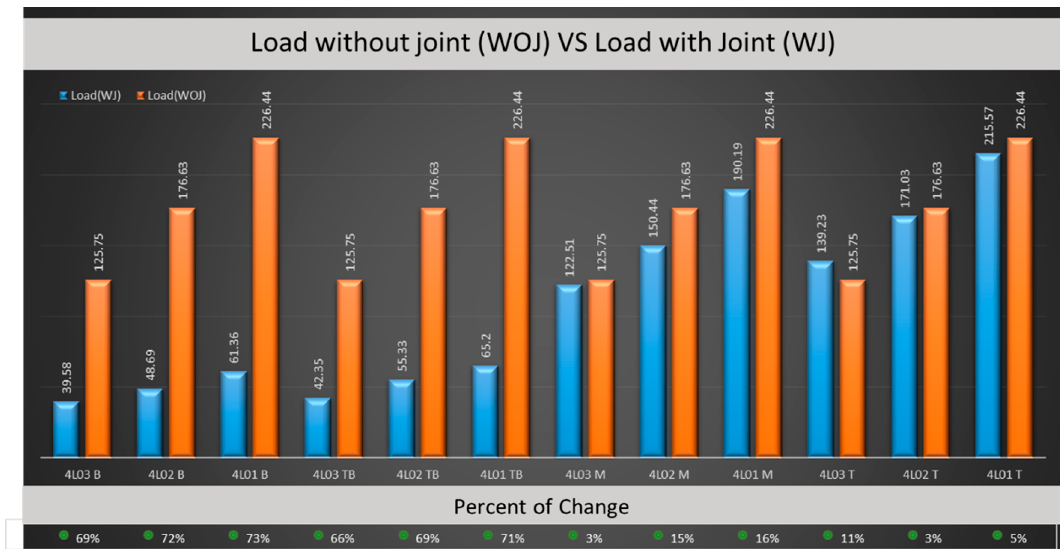
Figure 20. A comparison of TDGLC +TG (WJ) and without joint (WOJ). This paper tested only the tongue and groove (TG) joint and only specimens with a cross-section of 100 mm. Further research can test different cross-sections to determine the load that affects different cross-sections and can compare and reference every cross-sec- tion of TDGLC.